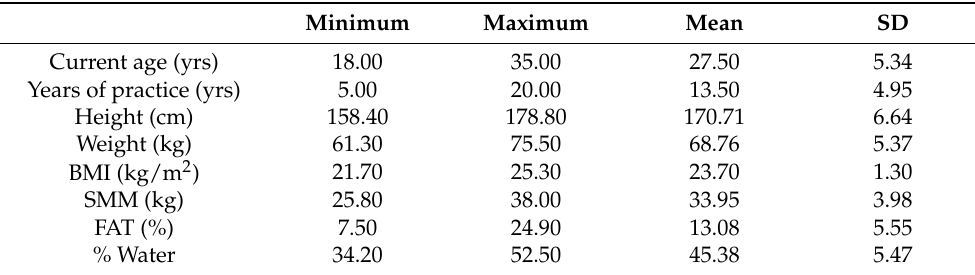
Table 1. Description of the study sample and anthropometric and body composition variables analysed in the initial descriptive study of Breaking athletes.